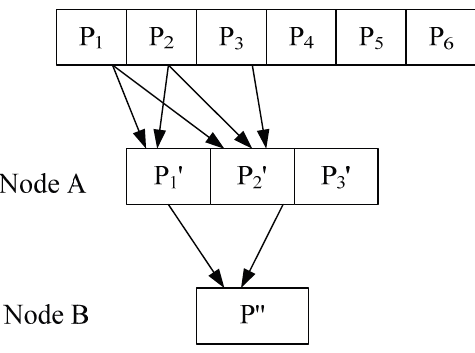
Figure 5. An intermediate node performing partial network